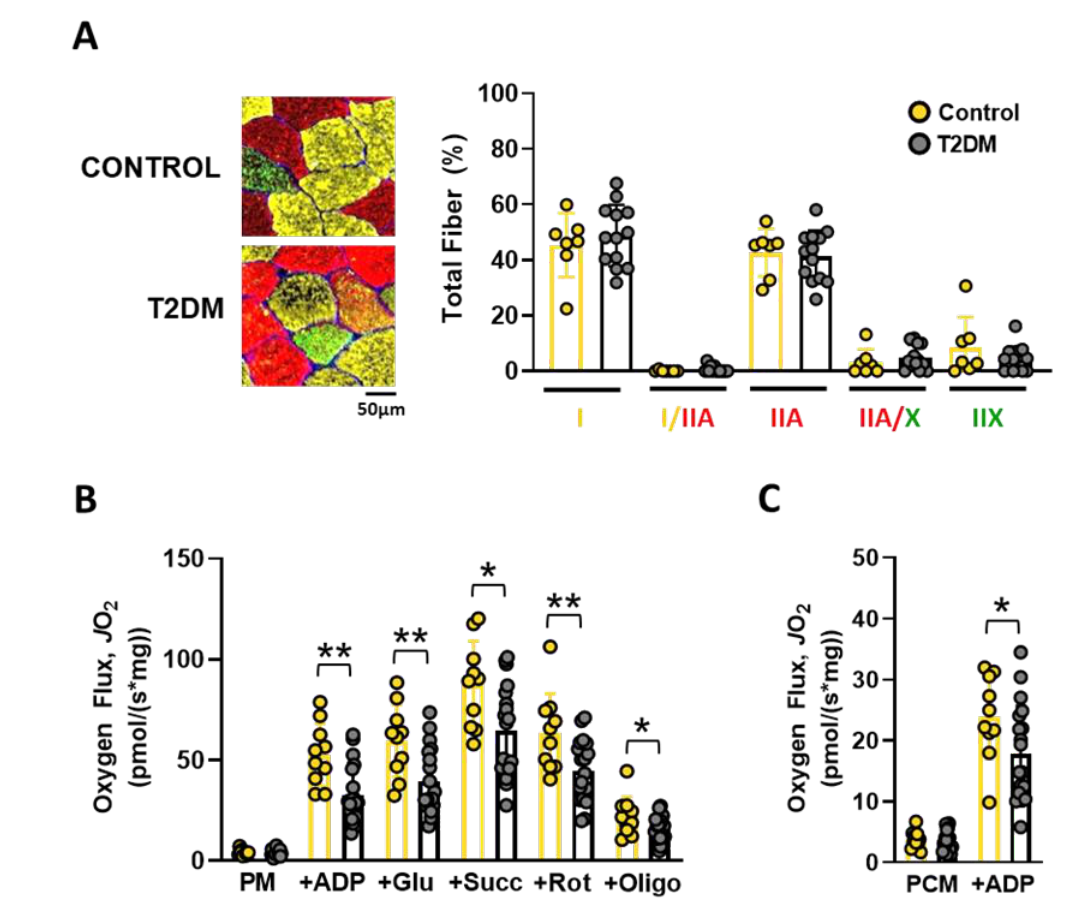
Figure 2. Muscle fiber type distribution and mitochondrial respiratory capacity in skeletal muscle of T2DM and non-diabetic controls. ( A ) (Left) Cross-sections of skeletal muscle biopsies denoting fibers expressing MyHC I (type I fibers, yellow), MyHC IIA (type IIA fibers, red) and MyHC IIX (Type IIX fibers, green). (Right) Quantification of fiber type distribution. ( B ) Quantification of carbohydrate-supported mitochondrial respiration in permeabilized muscle fibers of control (N = 10) and T2DM (N = 19). ( C ) Fatty-acid supported mitochondrial respiration in permeabilized muscle fibers of control (N = 10) and T2DM (N = 19). Data are presented as mean ± SD. * p < 0.05; ** p <